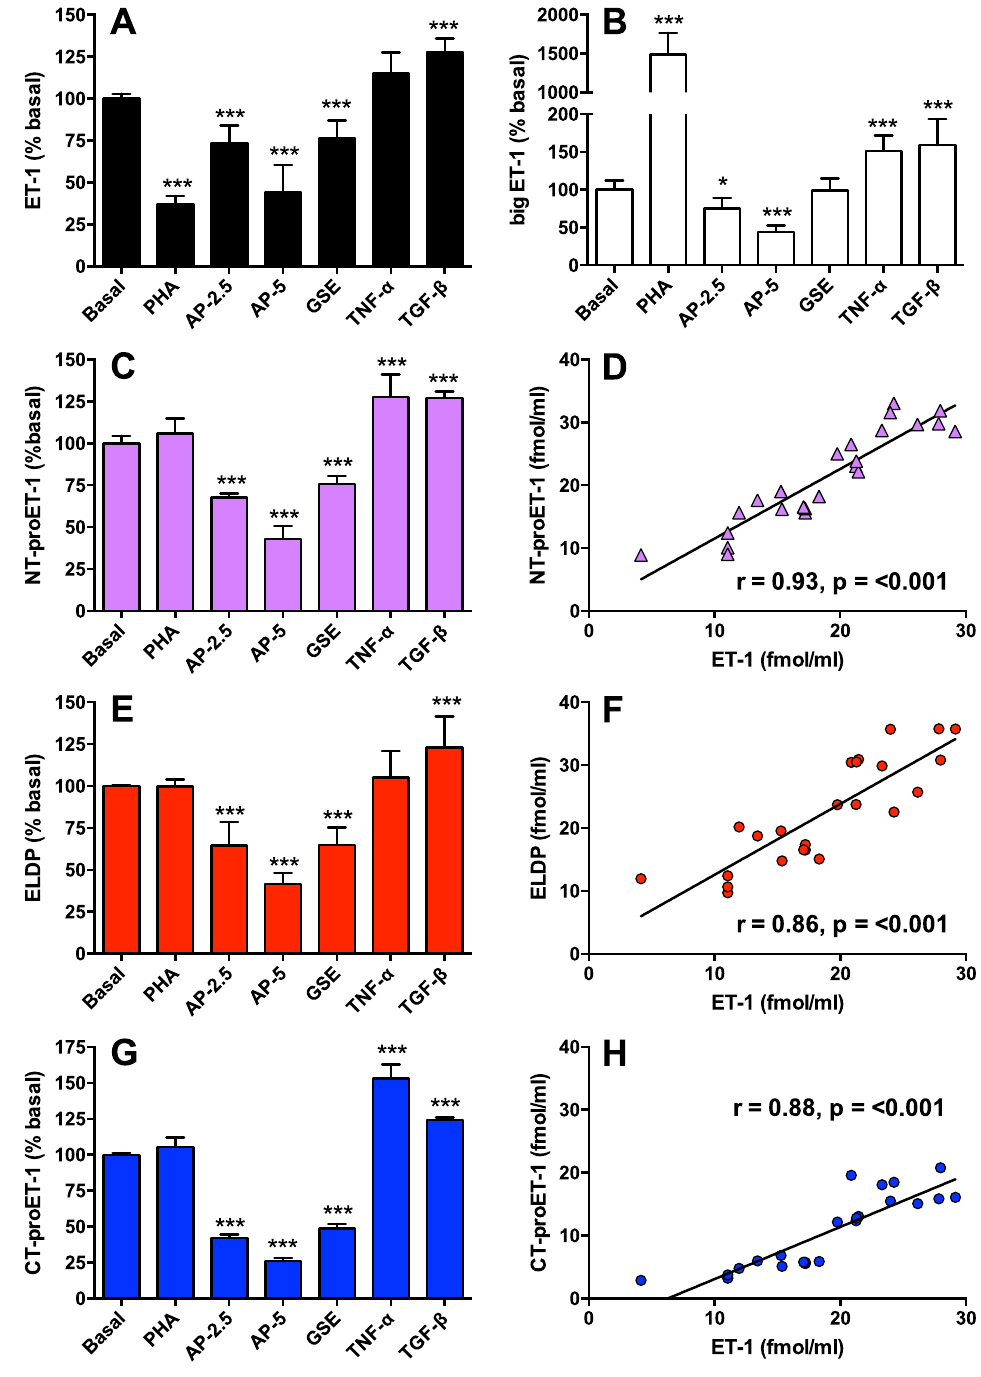
Figure 3. Correlation between secretion of ET-1 and proET-1 peptides from human aortic endothelial cells. Confluent cultures were incubated for 6 h in basal medium alone, or with 1 mM phosphoramidon (PHA), 2.5 or 5 µ g/ml apple procyanidin pentamer (AP-2.5, AP-5), 5 µ g/ml grape seed extract (GSE), 10 ng/ml TNF α or 1 ng/ml TGFß. All peptides were measured using specific sandwich ELISAs, and converted to % basal release ( A , B , C , E and G ). Results are mean ± SD from 4 experiments. Significant differences were determined by ANOVA with Bonferroni correction for multiple comparisons ( * P = < 0.05; *** P = < 0.001). ( D , F ) and ( H ) show correlations between secretion of ET-1 and the respective proET-1 peptides under the different incubation conditions (excluding data obtained with